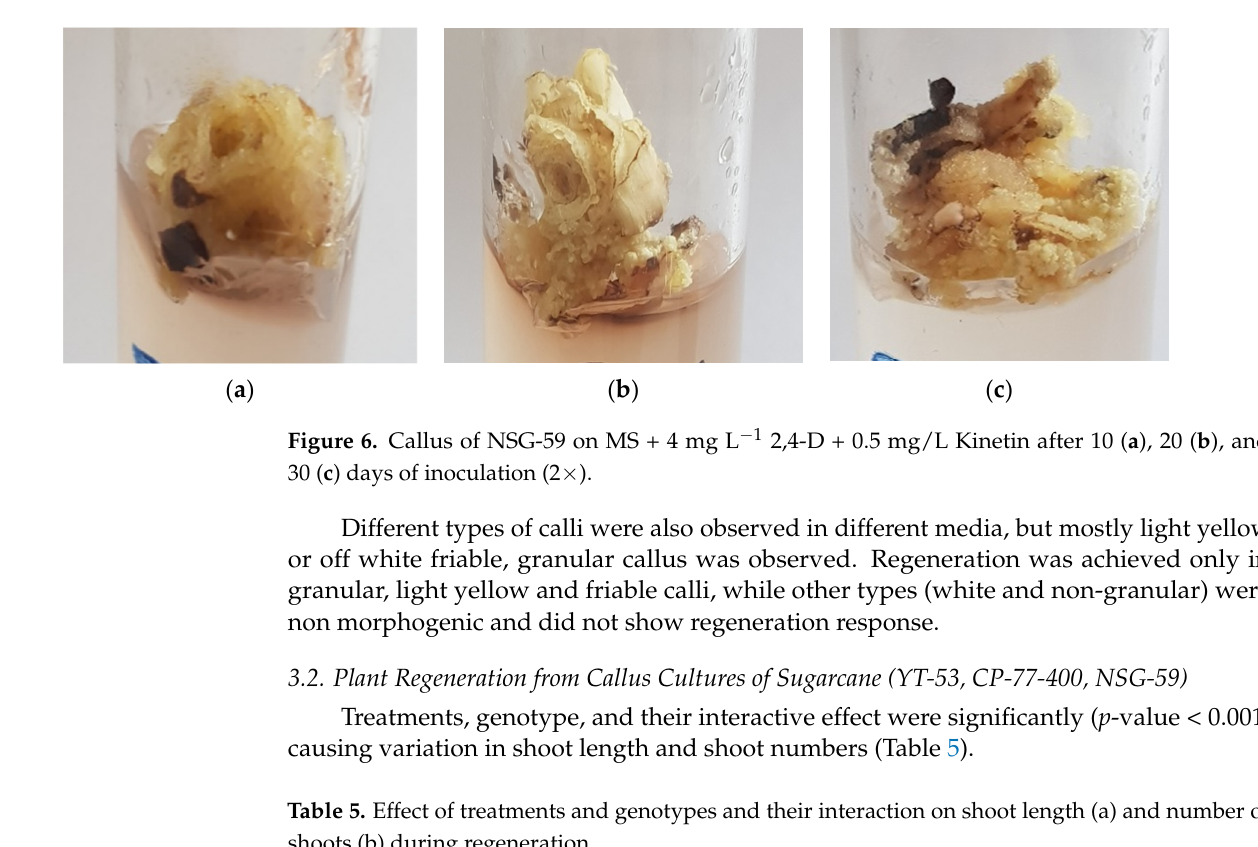
Table 5. Effect of treatments and genotypes and their interaction on shoot length (a) and number of shoots (b) during regeneration.